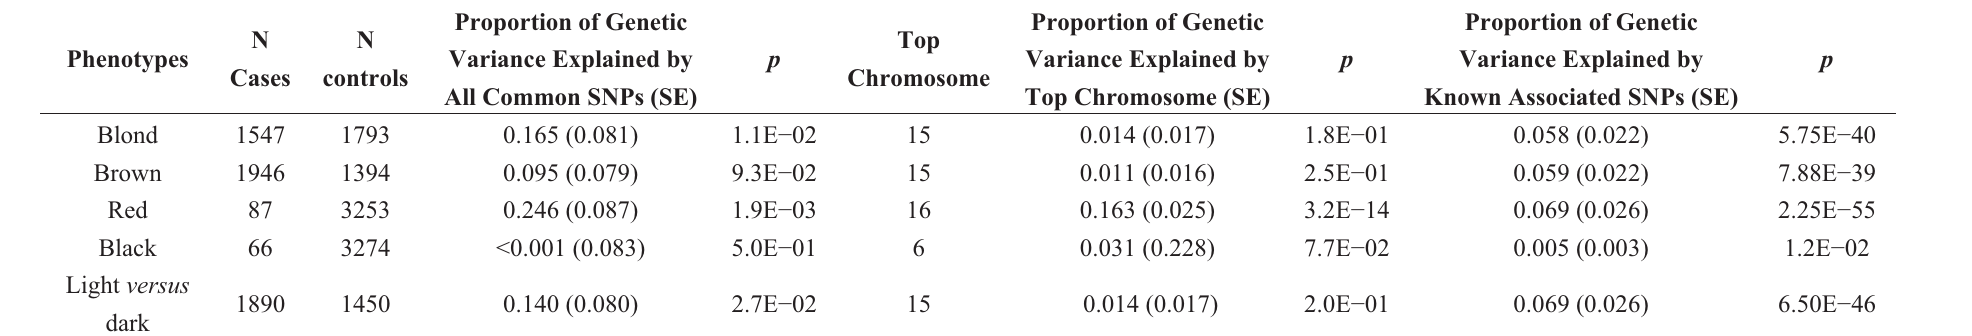
Table 3 The explained genetic variance of the hair color liability scale for autosomal common SNPs in GCTA.